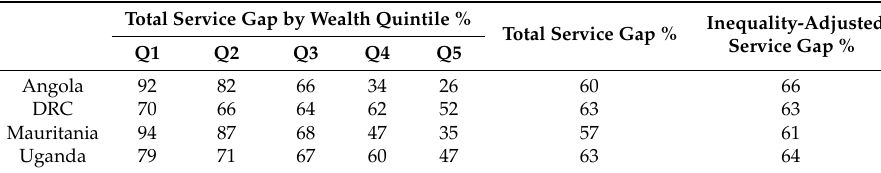
Table 4. Composition of the inequality-adjusted service gap.